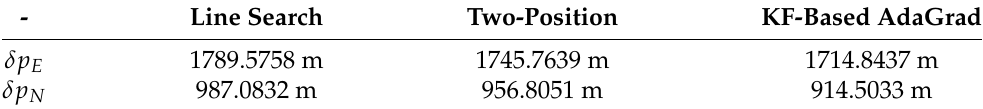
Table 9. RMS of position